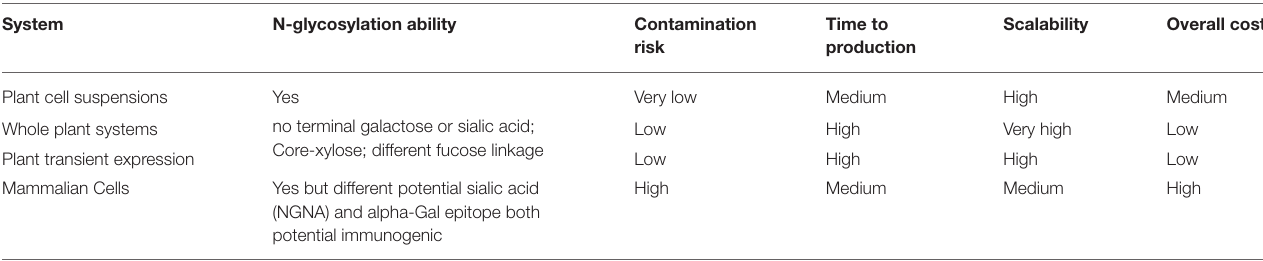
TABLE 2 | Comparison among the available systems for biopharmaceutical production.